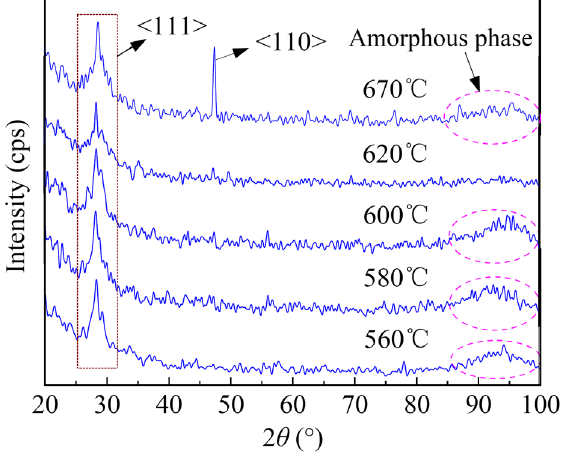
Figure 2. XRD spectra of PSNF samples deposited at different